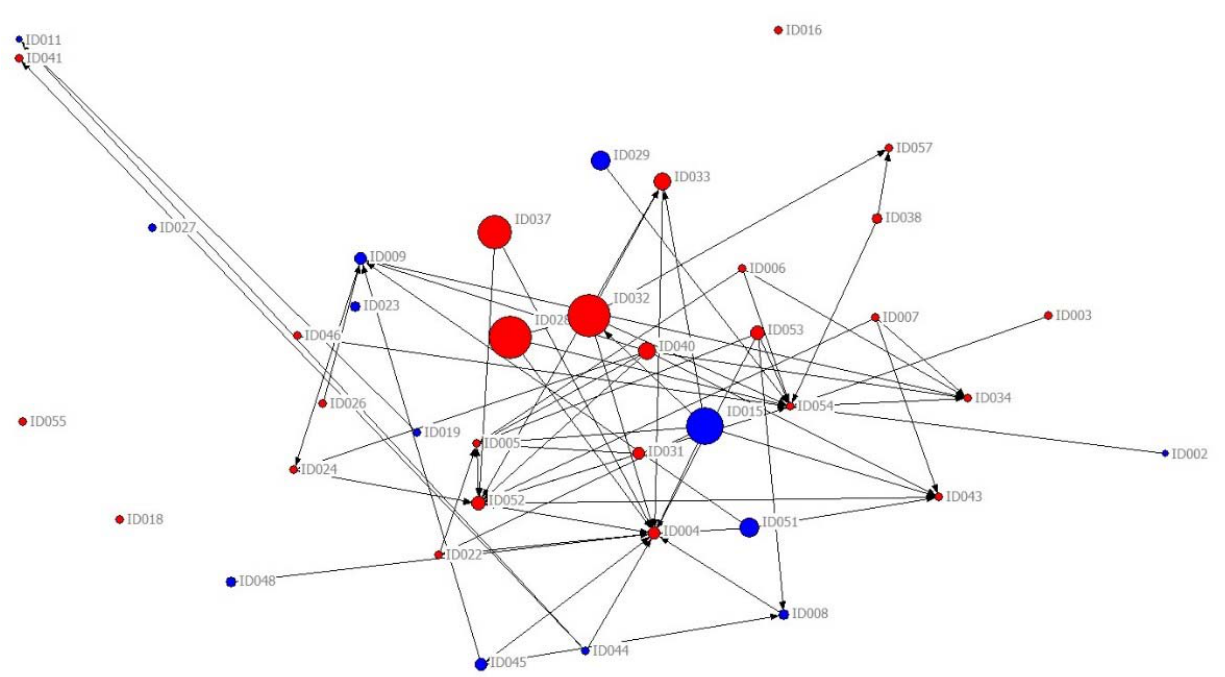
J. Open Innov. Technol. Mark. Complex. 2021 , 7 , x FOR PEER REVIEW Figure 2. Market knowledge network. Figure 2. Market knowledge network.